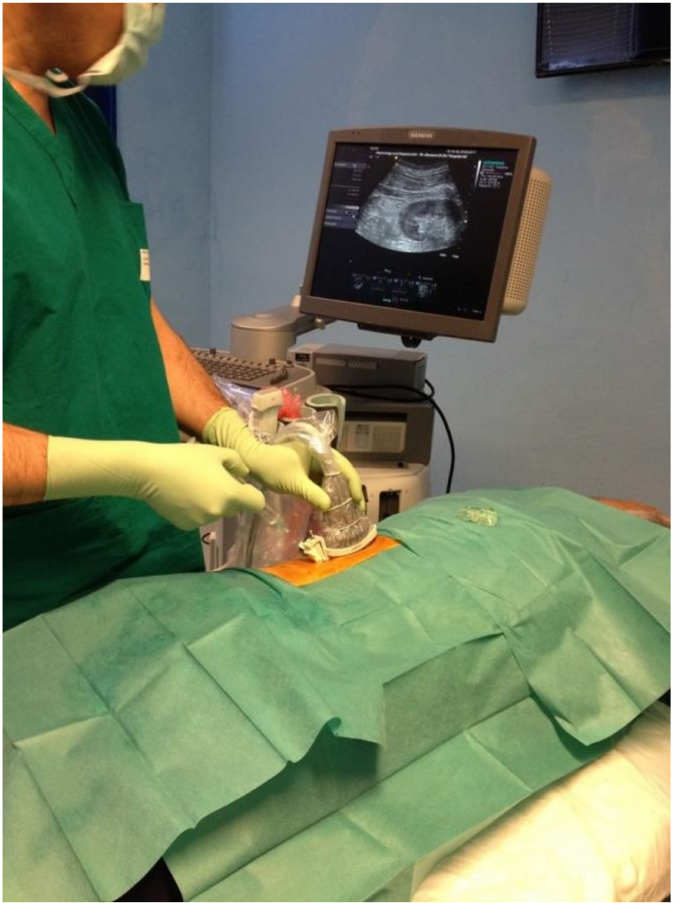
Figure 2. The correct position of the operator with respect to the patient is demonstrated. A needle guide system was mounted on the convex probe. The whole procedure is conducted in a sterile state, and the sterile sheets surrounding the uncovered skin areas are not